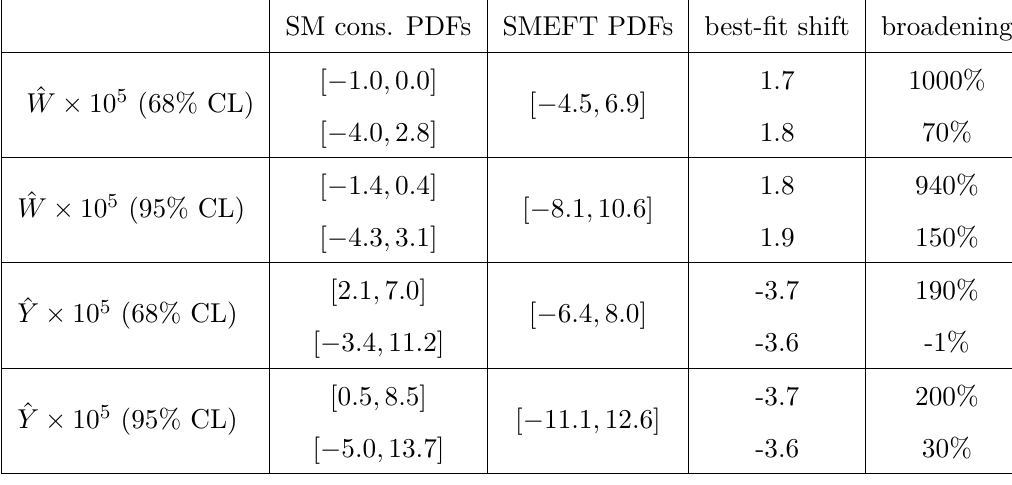
Table 7 . Same as table 6 for the 68% and 95% CL marginalised bounds on the ˆ W and ˆ Y param- eters obtained from the two-dimensional ( ˆ W , ˆ Y ) fits that include the HL-LHC pseudo-data for NC and CC Drell-Yan distributions. The input PDF set for the analysis done using fixed SM PDFs (corresponding to the results displayed in the column “SM cons. PDFs”) is a conservative PDF set that does not include any of the high-mass distributions or the HL-LHC projections nor the Run I and Run II high-mass dataset listed in table 2. The limits obtained from the simultaneous fit of PDFs and Wilson coefficients (corresponding to the results displayed on the column “SMEFT PDFs”) are the same as those in table